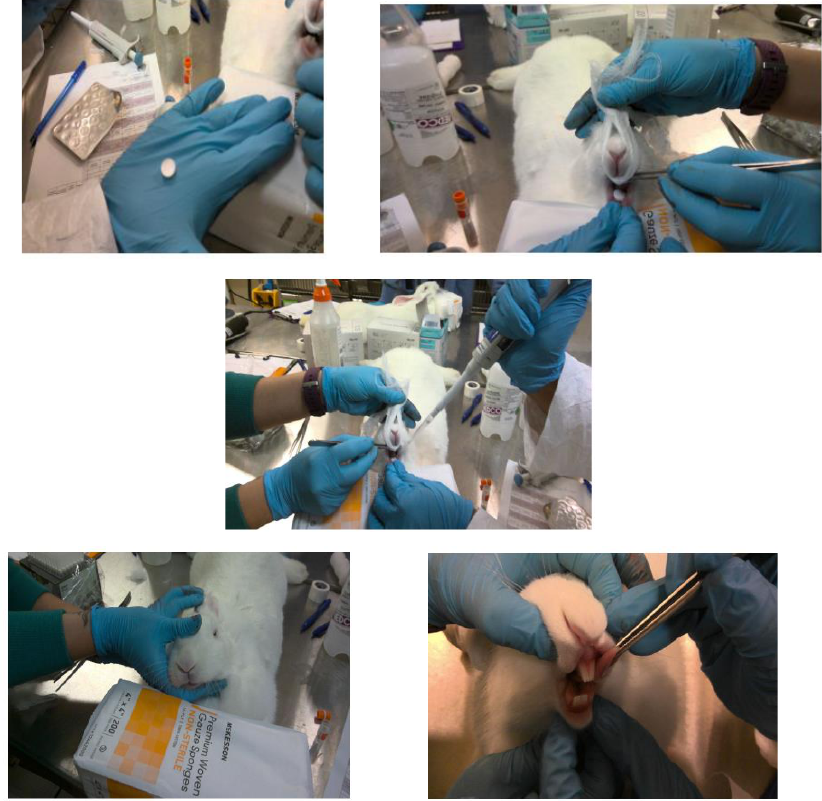
Figure 1. Placement of oxytocin fast-dissolving tablets in the sublingual cavity of anesthetized rab- bits.